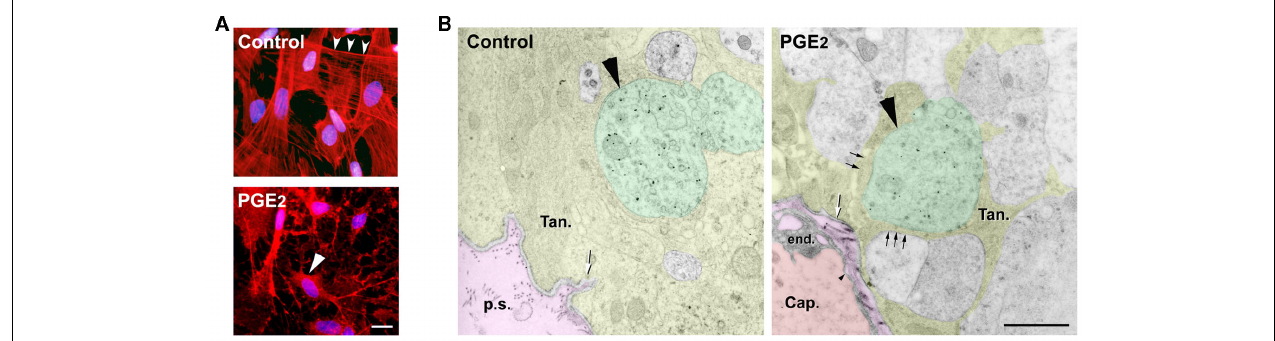
FIGURE 6 | Prostaglandin E 2 promotes the retraction of tanycytic processes in vitro and induces neuroglial plasticity causing GnRH neurosecretory terminals to advance toward the pericapillary space in isolated median eminence explants. (A) Tanycytes in culture were stained with Alexa Fluor 568-conjugated phalloidin to visualize filamentous actin (red) and with Hoechst to stain nuclei (blue). In control unstimulated tanycyte cultures, actin was localized adjacent to the cell membrane (top panel, cortical actin, arrowheads) and was also diffused throughout the cytoplasm. PGE 2 treatment (280nM, 30min) promoted tanycyte retraction (bottom panel, long arrowhead). (B) Electron micrographs of GnRH immunoreactive axon terminals (big arrowhead, green) from female rat median eminence explants